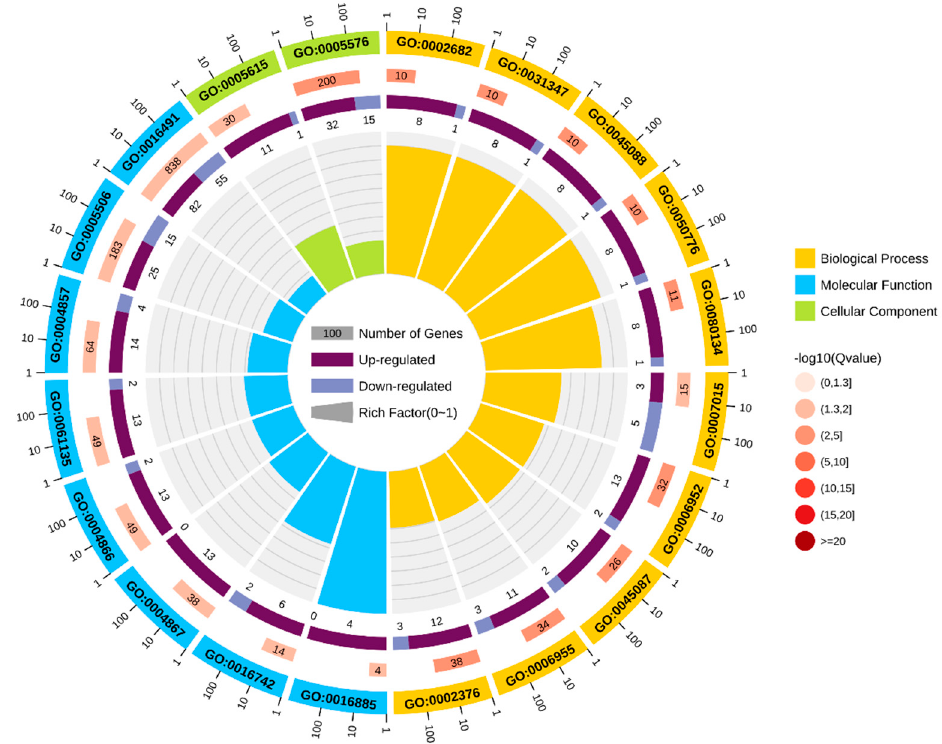
Figure 3. Top 20 GO term enrichment of DEGs in LW-13 compared with G88. From the outside to the inside, the first circle represents the enriched GO classification where the different colors represent different classifications, and the numbers outside the circle represent the coordinate ruler of the number of genes. The second circle represents the number of genes corresponding to the classification and the Q value, where the longer the bar indicates a higher number of genes, and the darker red color indicates a smaller Q value. The third circle represents the ratio of up- and down-regulated genes, where dark purple represents the up-regulated genes, light purple represents the down-regulated genes, and the numbers of the corresponding bottom represent the up-regulated genes number or down-regulated genes number. The fourth circle represents the rich factor value of each GO term, and each cell represents 0.1.